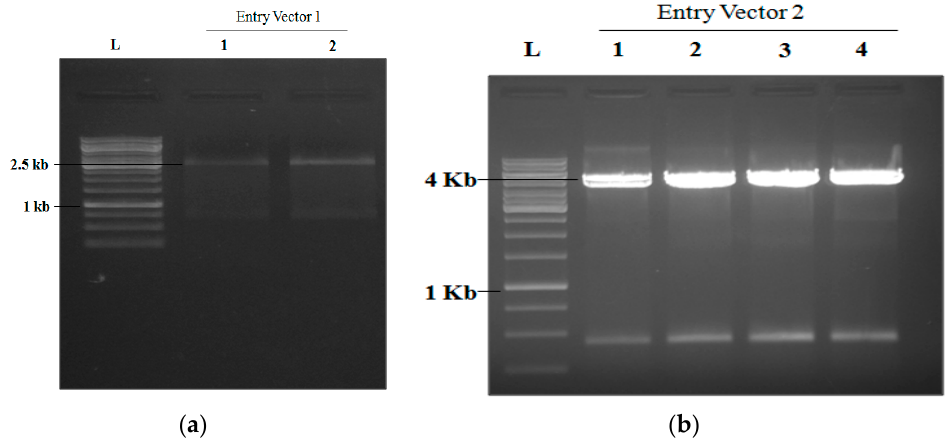
Figure 1. The digestion of Entry Vector with endonuclease BsaI is given in figures ( a ) EV1 and ( b ) EV2. L, 1 kb DNA ladder (Invitrogen, MA, USA).